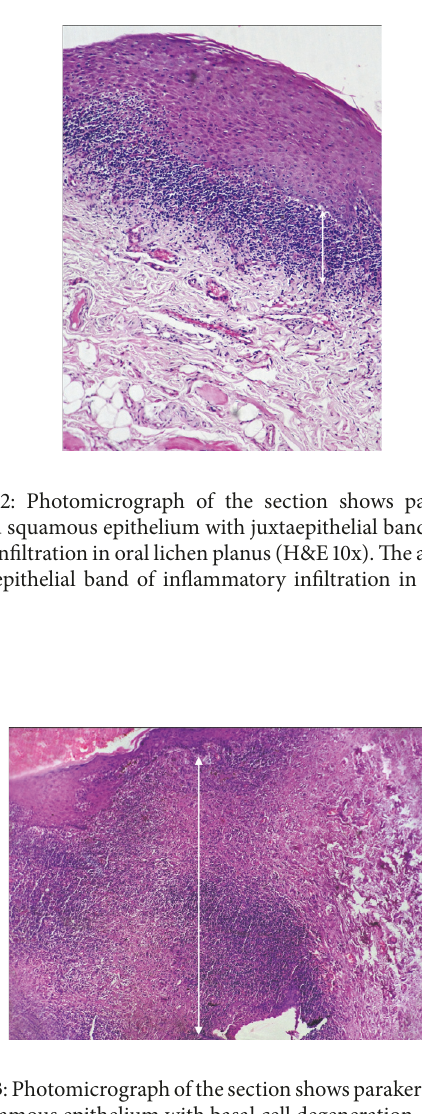
Figure3:Photomicrographofthesectionshowsparakeratoticstrat- ified squamous epithelium with basal cell degeneration. The arrows refer to inflammatory infiltration extending deep into reticular zone of lamina propria in oral lichenoid reaction (H&E